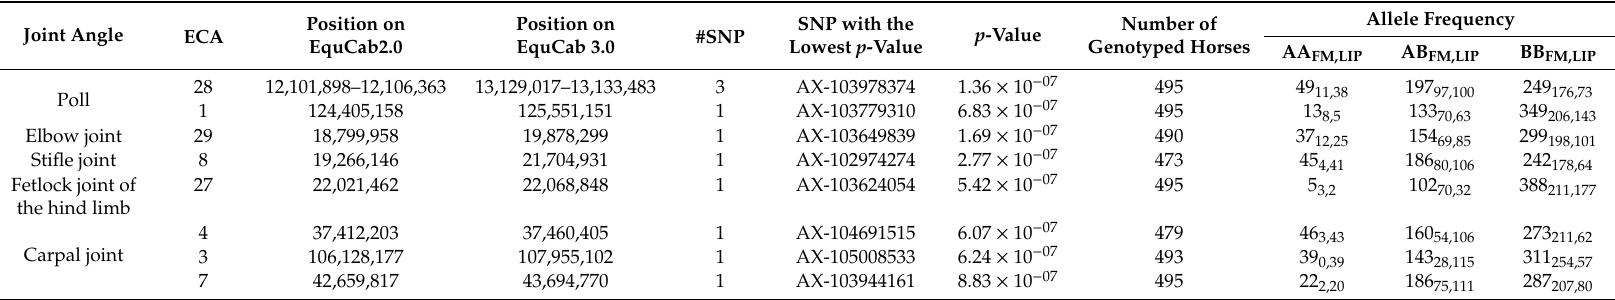
Table 3. Best associations by trait (only markers with p < 10 − 6 are reported) for the genome-wide association studies of Franches-Montagnes (FM) and Lipizzan (LIP) joint angle